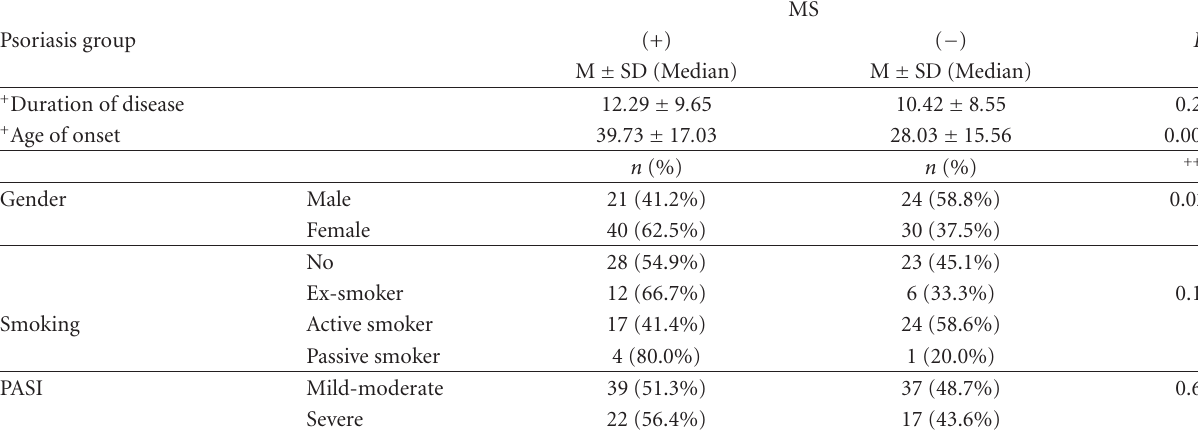
Table 3: The associations of MS with patient characteristics in psoriasis patients.